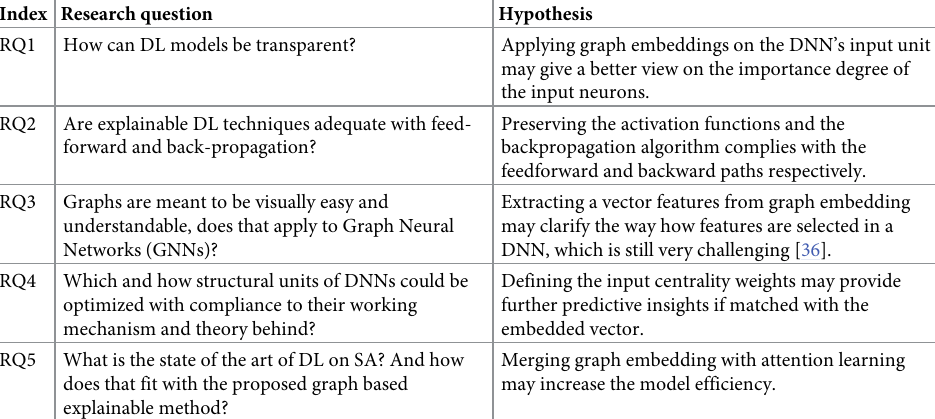
Table 1. The proposed research and the following hypotheses.